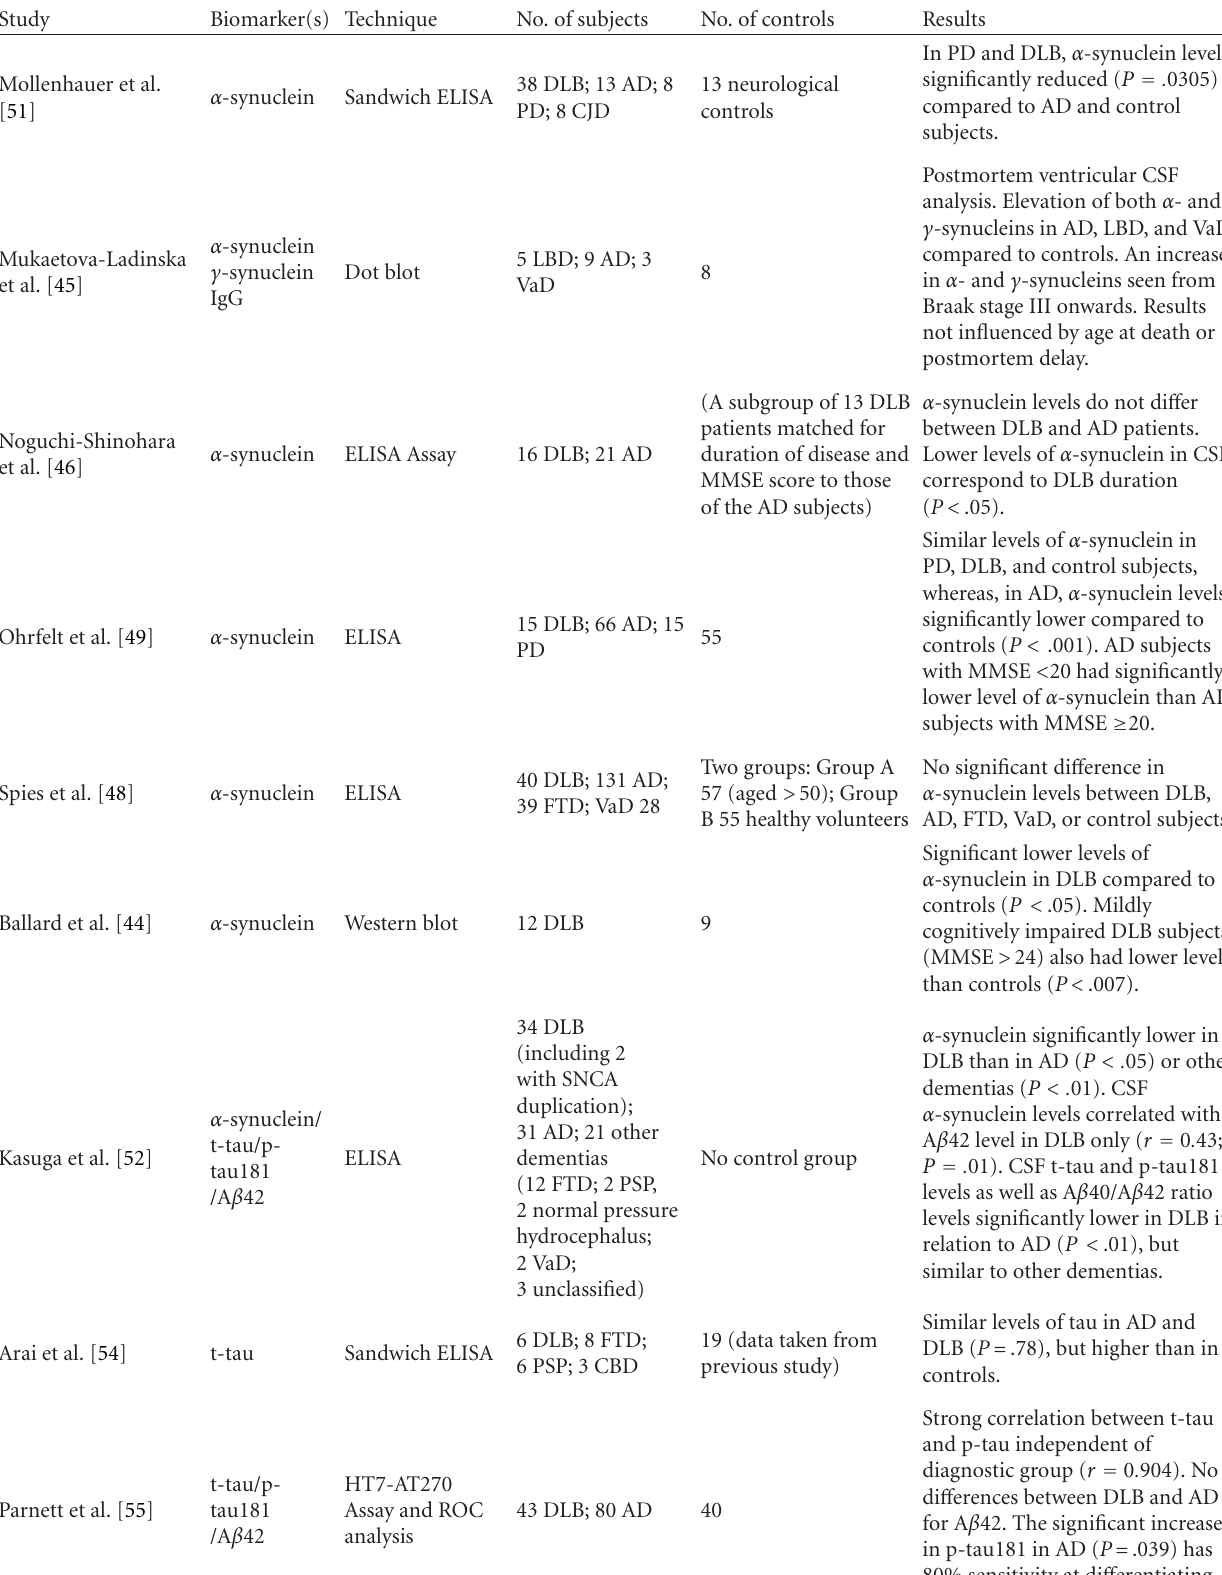
Table 3: CSF biomarkers for